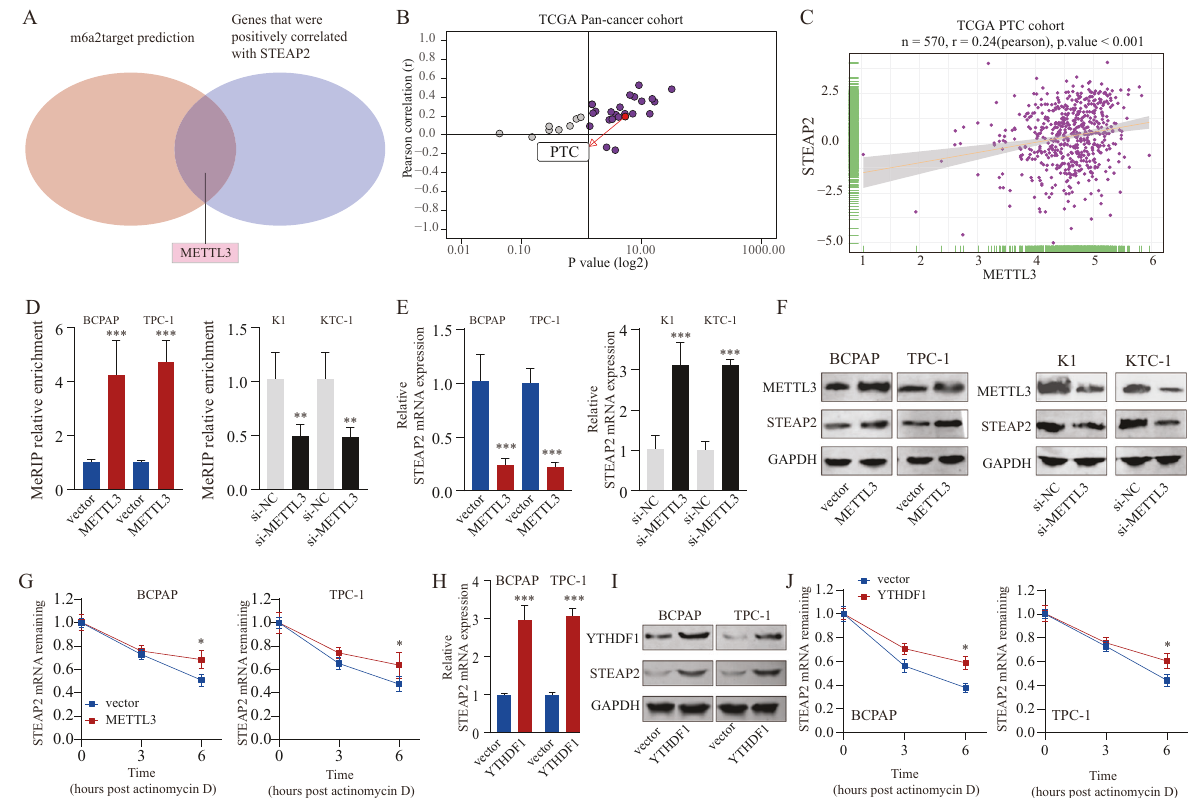
Fig. 6 METTL3 enhances STEAP2 mRNA stability via an m6A – YTHDF1-dependent pathway. A By retrieving the TCGA dataset and using algorithms (m6a2target), m6a “ writer ” protein METTL3 were identi fi ed to be able to potentially interact with STEAP2 mRNA. Pearson correlation analysis between STEAP2 and METTL3 mRNA levels in Pan-cancer cohort ( B ) and PTC cohort ( C ) retrieved from TCGA. D MeRIP- qPCR analysis was employed to demonstrate METTL3-mediated STEAP2 m6A modi fi cations. The m6A modi fi cation of STEAP2 was increased on upregulation of METTL3, while it was depleted on METTL3 silencing. The expression levels of STEAP2 in METTL3-overexpressing and METTL3 knockdown PTC cells were detected by qRT-PCR ( E ) and western blot ( F ). G STEAP2 mRNA level in METTL3-overexpressing or METTL3- knockdown PTC cells treated with actinomycin D at the indicated time points were detected by qRT-PCR. The expression levels of STEAP2 in YTHDF1-overexpressing PTC cells were detected by qRT-PCR ( H ) and western blot ( I ). J STEAP2 mRNA level in TYTHDF1-overexpressing PTC cells treated with actinomycin D at the indicated time points were detected by qRT-PCR. All data are presented as the mean ± standard deviation of three independent experiments. * P < 0.05, ** P < 0.01, and *** P <